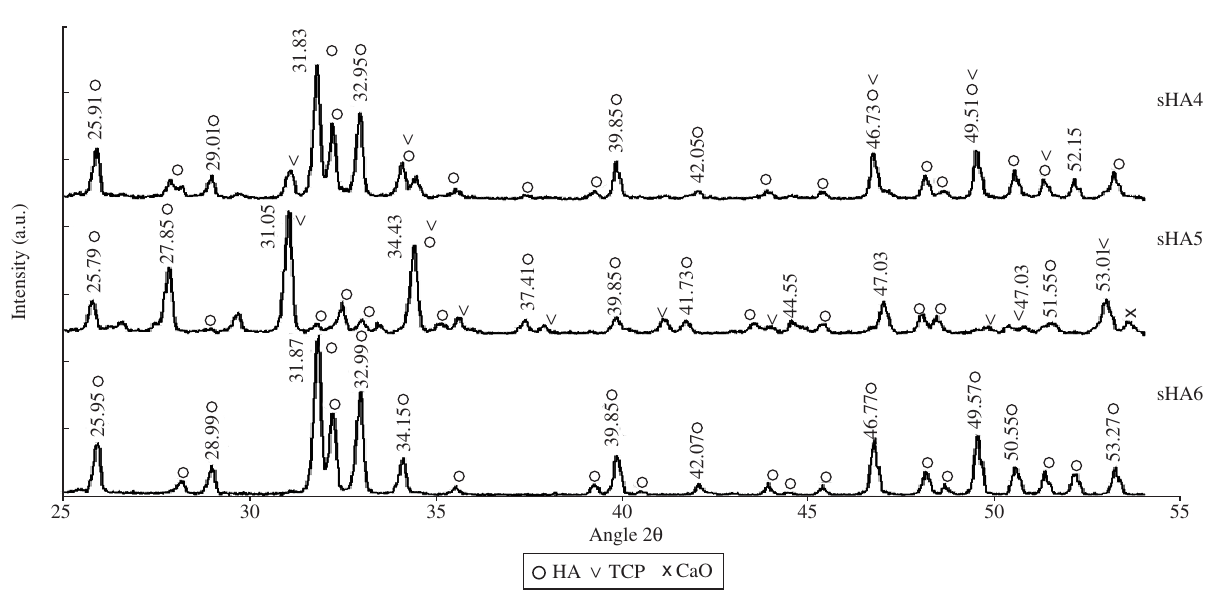
Figure 5. XRD patterns of sintered products from methods 4, 5 and